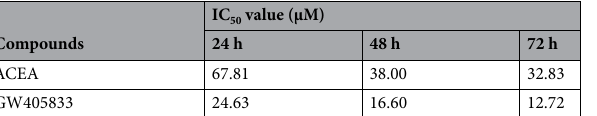
Table 2. The estimated IC 50 values of ACEA and GW405833 on MDA-MB-231 cell viability. The IC 50 values were computed using a nonlinear regression model from results in Fig. 3 by GraphPad Prism 9.1.2.